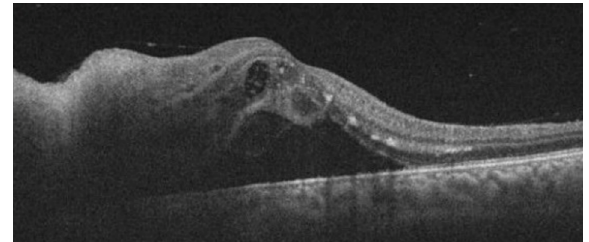
Figure 4: A serous macular detachment